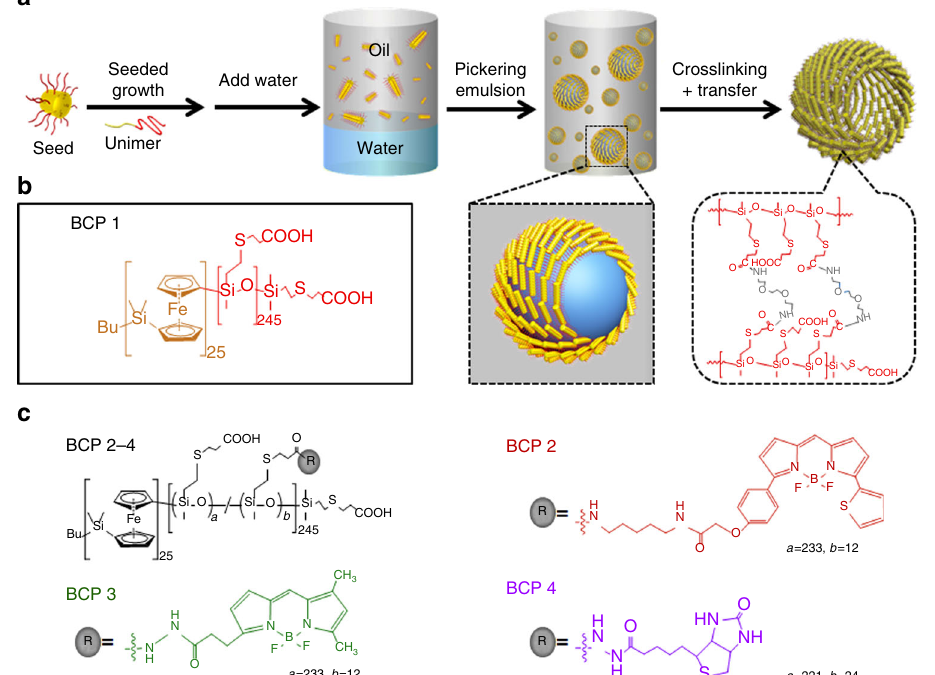
Fig. 1 Design and construction of chemically functionalized block copolymer (BCP) colloidosomes. a General procedure for formation of colloidosomes. PFS 25 - b -PMVSCOOH 245 (BCP1) unimers undergo self-assembly in 2-ethyl-1-hexanol (EHOH) into core-shell cylindrical micelles of controlled length by a seeded growth process of crystallization-driven self-assembly (CDSA). Mixing the micelle dispersion in EHOH with water or aqueous solutions of molecular cargoes (proteins, dyes and dextran) produces water-in-oil Pickering emulsions, which are stabilized by a membrane of closely packed BCP1 cylindrical micelles ( inset ). Crosslinking the membrane with 2,2 ʹ -(ethylenedioxy)bis(ethylamine) (EDEA) followed by removal of the oil layer and subsequent dialysis results in transfer of the colloidosomes into bulk isopropanol or aqueous solution ( inset ). b Chemical structure of BCP1. c Chemical derivatives of BCP1 containing BODIPY fl uorophores (BCP2, red ; BCP3, green ) or biotin residues (BCP4) covalently linked to the PMVSCOOH block. Cylindrical micelles of BCP2 and BCP3 are prepared in EHOH by CDSA using BCP1 seeds in the presence of mixtures of BCP1/BCP2 or